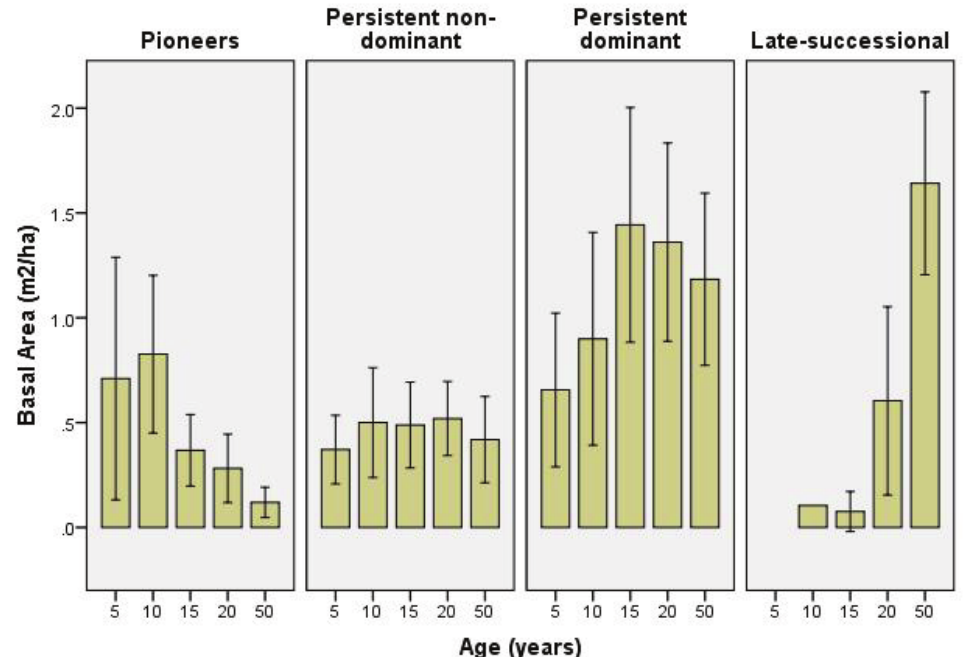
Figure 3. Basal area within successional groups across seasonal semi-evergreen forest stands, with abandonment times ranging from 5 to 50 years in the Yucatan Peninsula